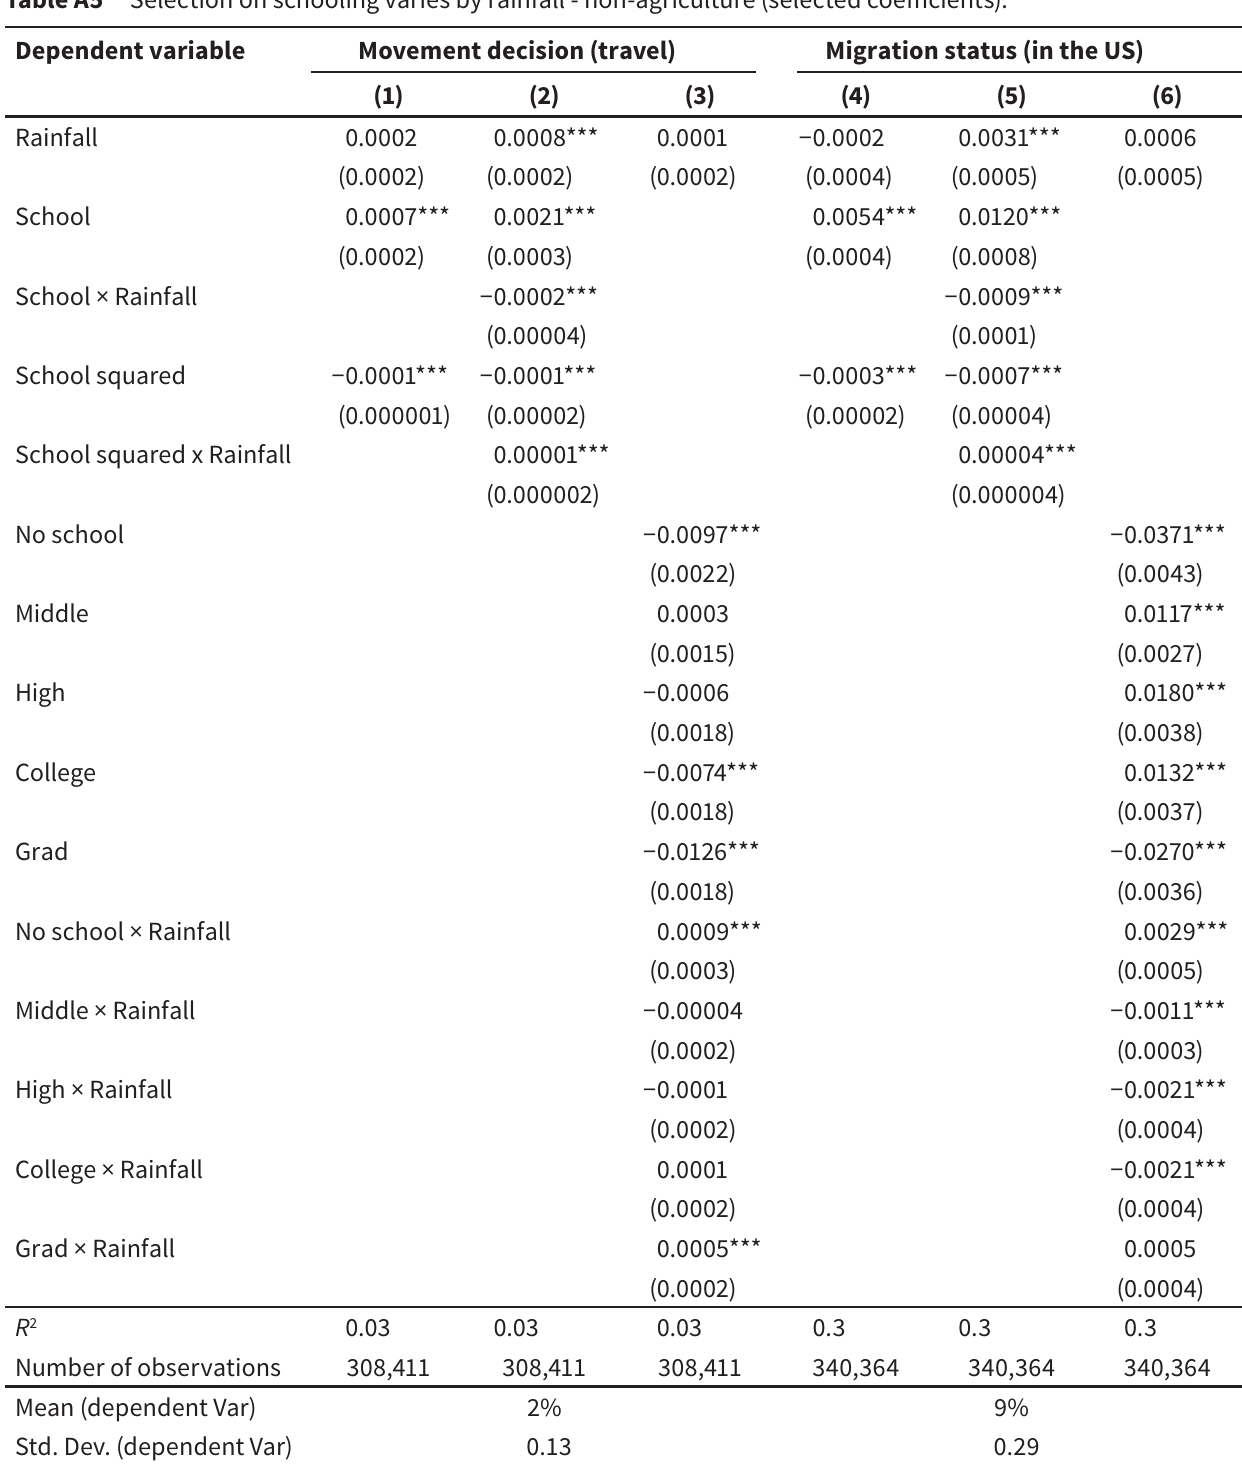
Selection on schooling varies by rainfall - non-agriculture (selected